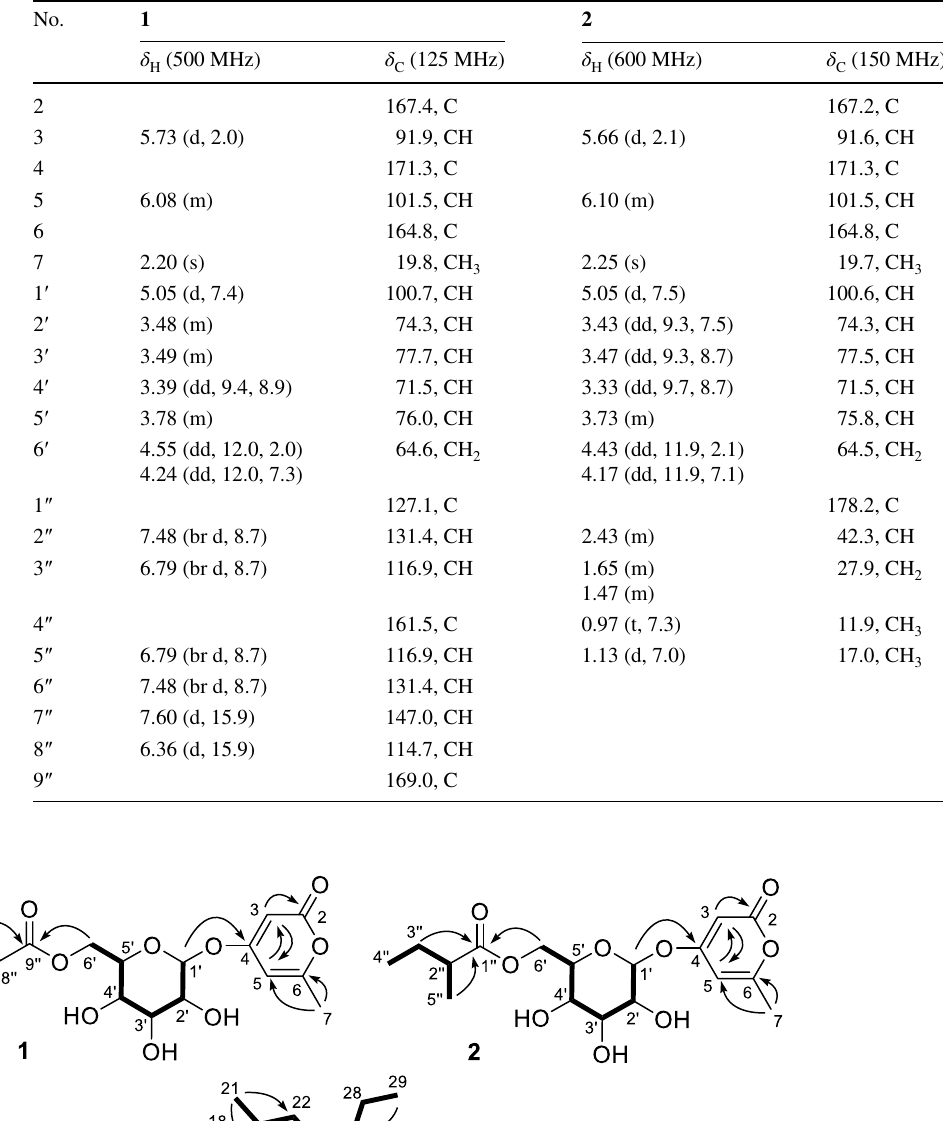
Table 1 1 H and 13 C NMR data of 1 and 2 in methanol- d 4 ( δ in ppm, J in Hz)